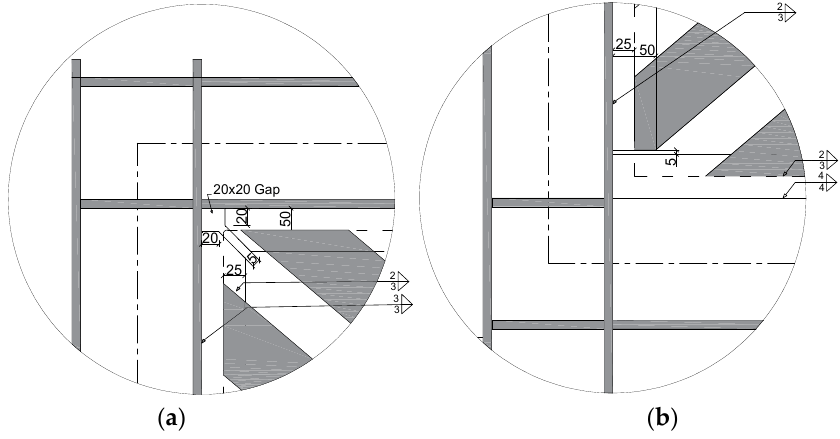
Figure 3 . ( a , b ) Top and bottom floor of beam-columns, fin plate, and infill web-strips connections and details, respectively. Unit (mm).